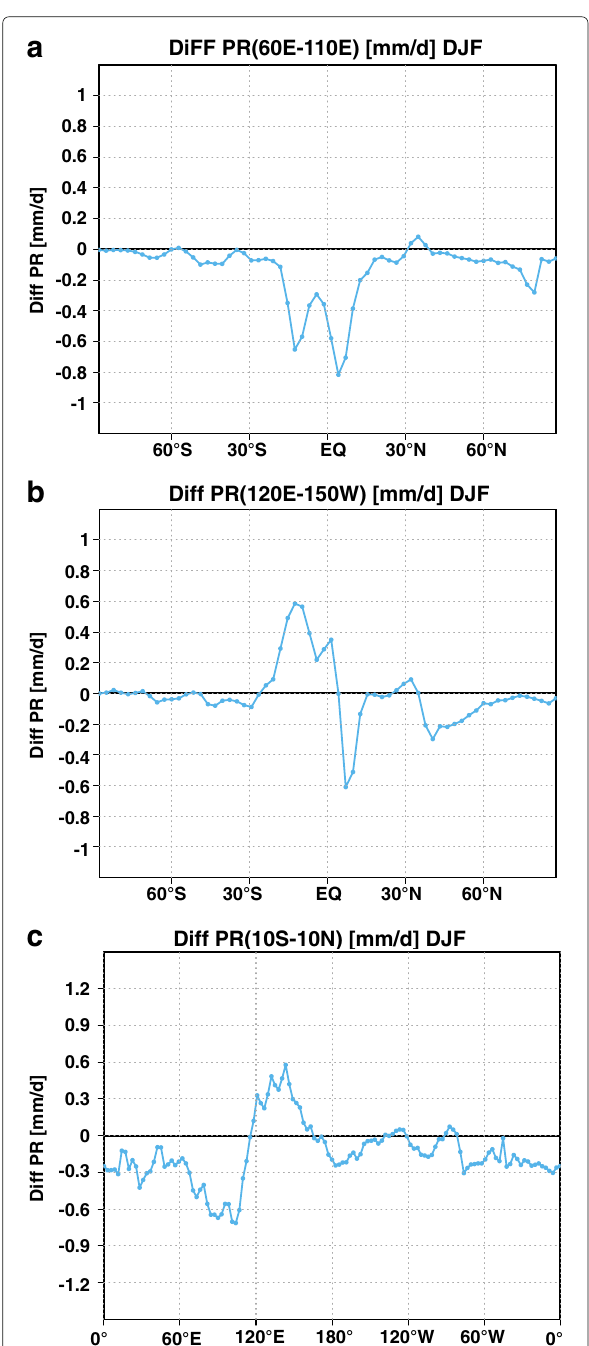
Fig. 10 As in Fig. 5, but for